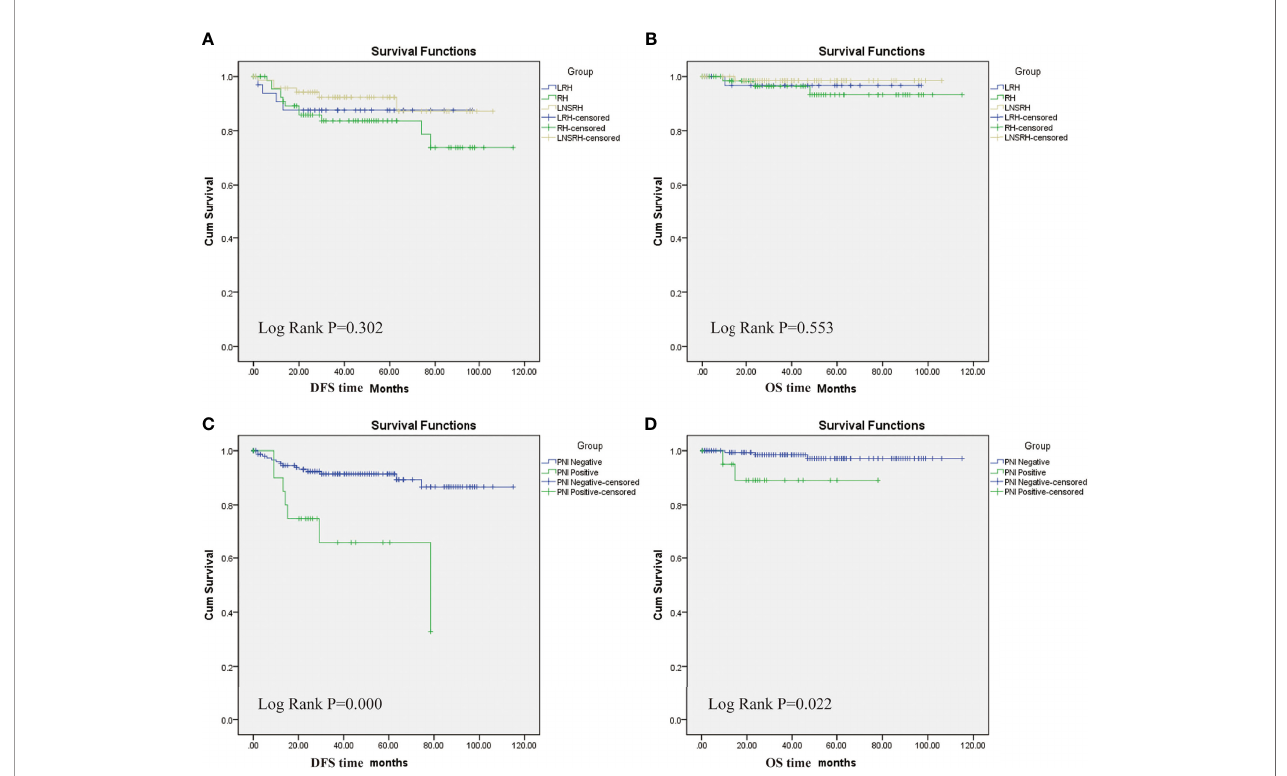
FIGURE 2 | Kaplan-Meier survival analyses. (A) Comparisons of disease-free survival (DFS) periods among three groups. (B) Comparisons of overall survival (OS) periods among three groups. There was no statistically signi fi cant difference in DFS and OS among the three groups. (C) DFS periods between positive and negative PNI groups. (D) OS periods between positive and negative PNI groups. PNI positive group had lower DHS and OS than the PCI negative